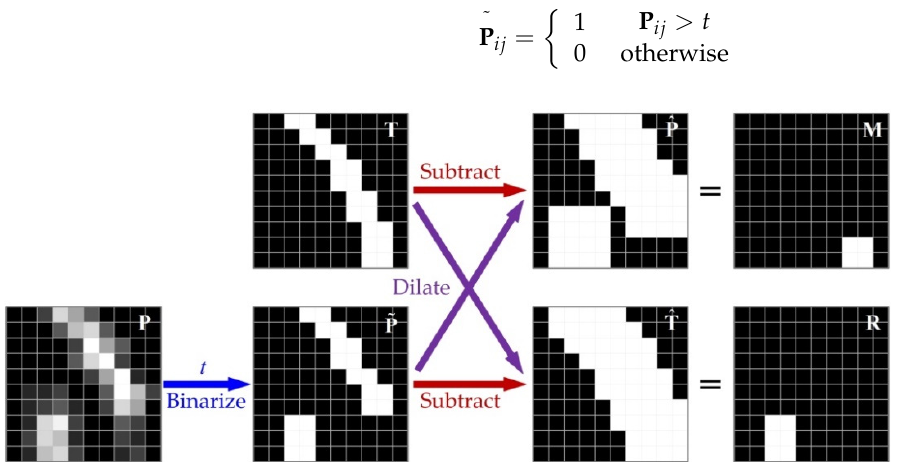
10 of 21 Figure 6. The tone mapped HDR image and the corresponding tube contour labels with different widths. ( a ) Tone mapped HDR image; ( b ) 1-pixel contour width; ( c ) 2-pixel contour width; ( d ) 4- pixel contour width; and ( e ) 8-pixel contour width. 3.3. Evaluation Metrics Tube contour detection is essentially binary classification for each pixel. Therefore, the classical metrics average precision (AP) and maximum F-measure at optimal dataset scale (MF-ODS) are employed to evaluate the performance of different methods on METCD. Here, the optimal dataset scale (ODS) refers to the best result at the optimal threshold across the entire validation set. We also notice that the number of contour pixels is significantly smaller than the number of non-contour pixels. In consequence, the maxi- mum Matthews correlation coefficient at optimal dataset scale (MCC-ODS), which is less influenced by imbalanced data [32], is adopted as another evaluation metric. In addition, for the same reason as using DC loss, we propose a new evaluation met-